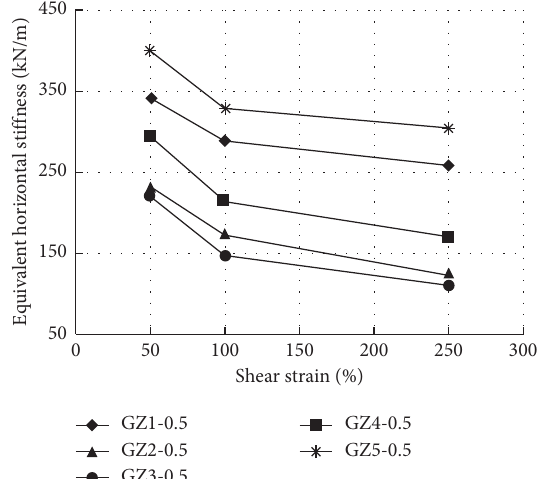
Figure 15: Relative equivalent horizontal stiffness with shear strain.